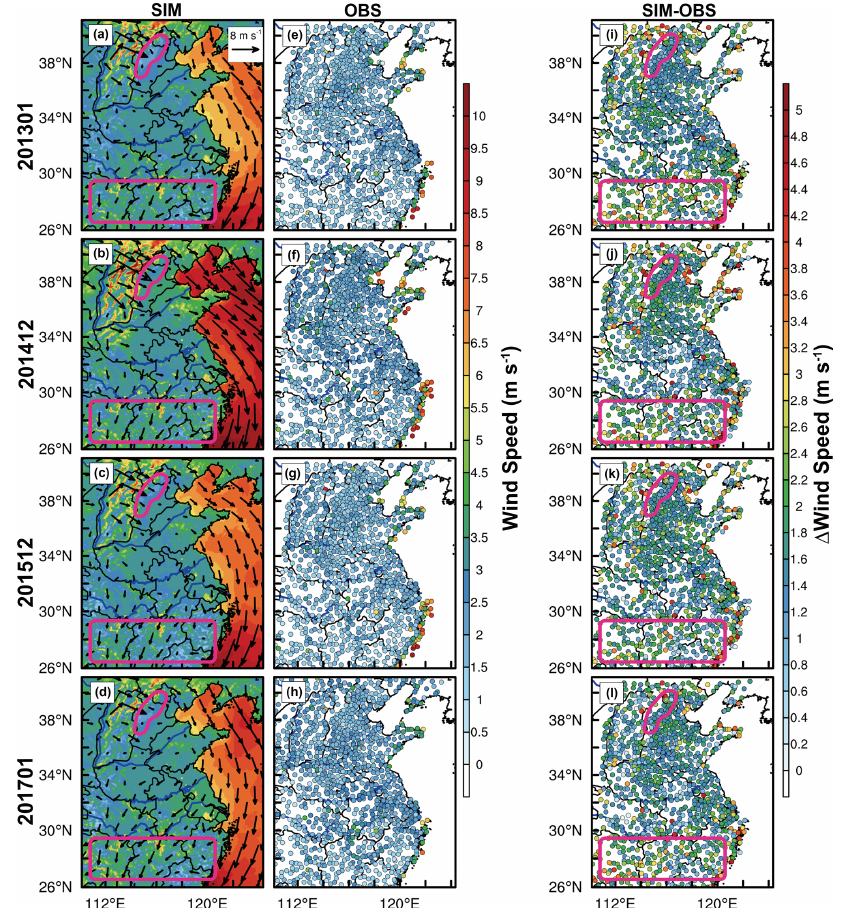
Figure 10. (a–d) Simulated and (e–h) observed wind speed at 10ma.g.l. and (i–l) the difference between simulated and observed wind speed. The purple rectangle indicates the area where the observed wind speed is significantly